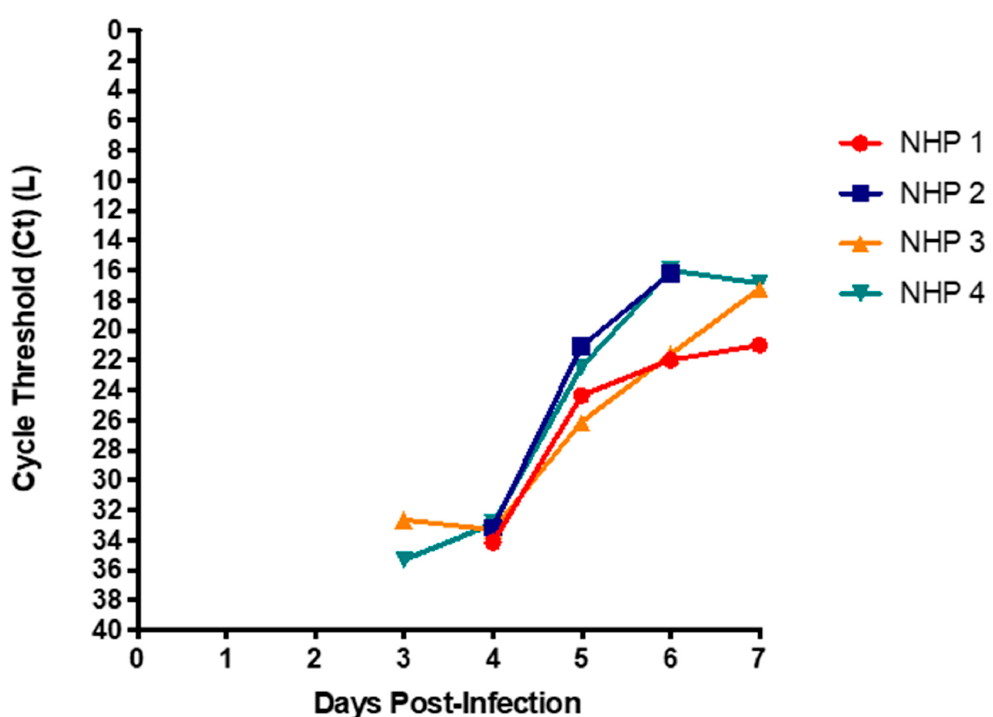
Figure 1. Cycle threshold (Ct) in blood during Ebola Virus Disease (EVD) . Blood was collected from four non-human primates 1–2 weeks before infection, and daily throughout the course of clinical disease. All samples were extracted, reverse transcribed, and then quantified using L-gene for EBOV RNA. Non-human primates (NHP) 1 ( • ), NHP 2 ( (cid:4) ), NHP 3 ( (cid:78) ), and NHP 4 ( (cid:72)